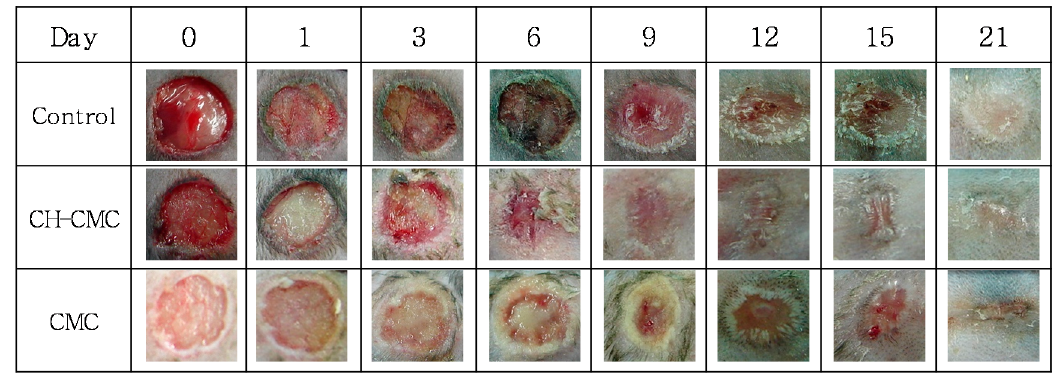
Figure 7. Photographs of wound healing observation by dates; control (non-treated wound), CH–CM (CH–CMC hydrogel-treated wound), CMC (CMC hydrogel-treated wound).